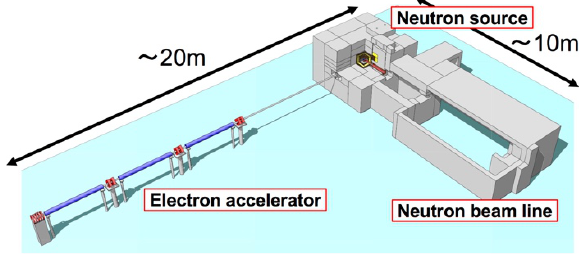
Fig. 1. Overview and features of the CANS at AIST [8]